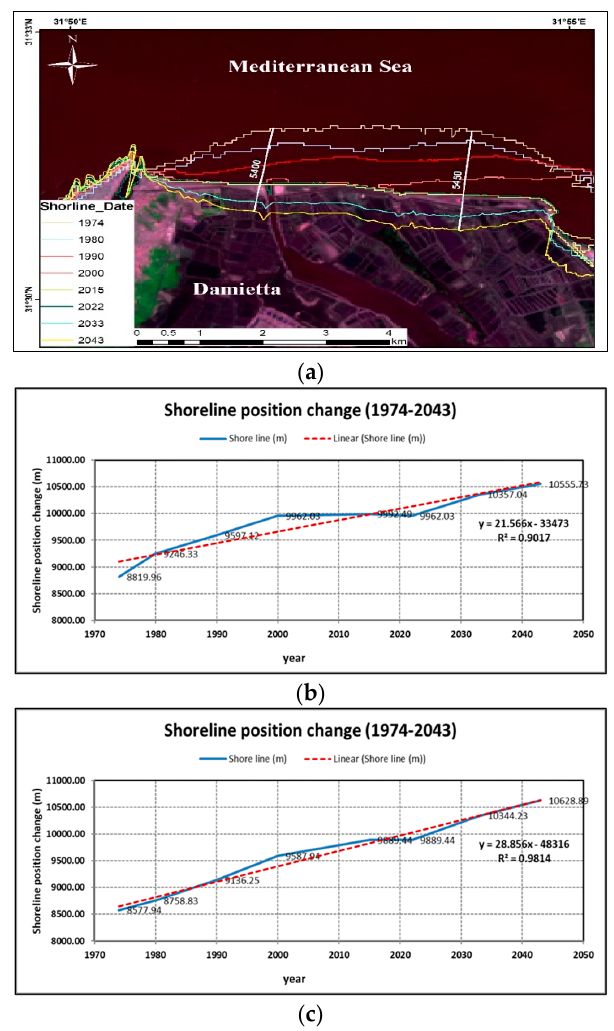
Figure 9. Shoreline changes over time at Damietta (1974–2043): ( a ) shoreline change at Damietta, ( b ) time series of changing the shoreline position at transect 5400, ( c ) time series of changing the shoreline position at transect 5450.